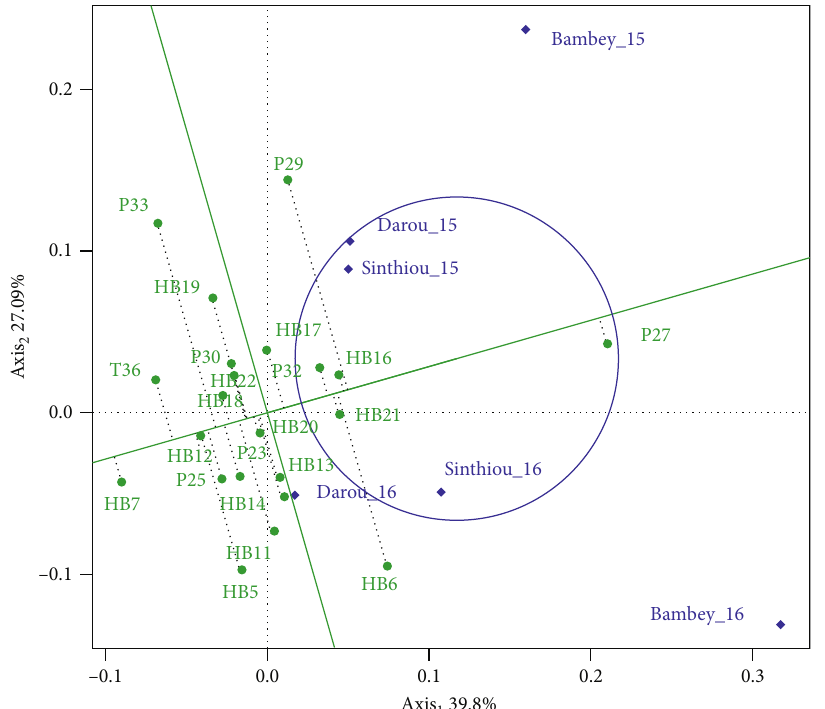
Figure 3: Average-environment coordination (AEC) view of sorghum hybrids and their parents for grain mold resistance performance and stability based on GGE biplot analysis. The green single-arrowed horizontal line represents the AEC abscissa, and the green vertical line represents the AEC ordinate. The direction of AEC abscissa arrowhead indicates higher yield. The vertical projections on the AEC abscissa indicate the stability of genotypes in either direction. Greater the projection, higher is the instability. Green and blue labels stand for genotypes and environments, respectively.